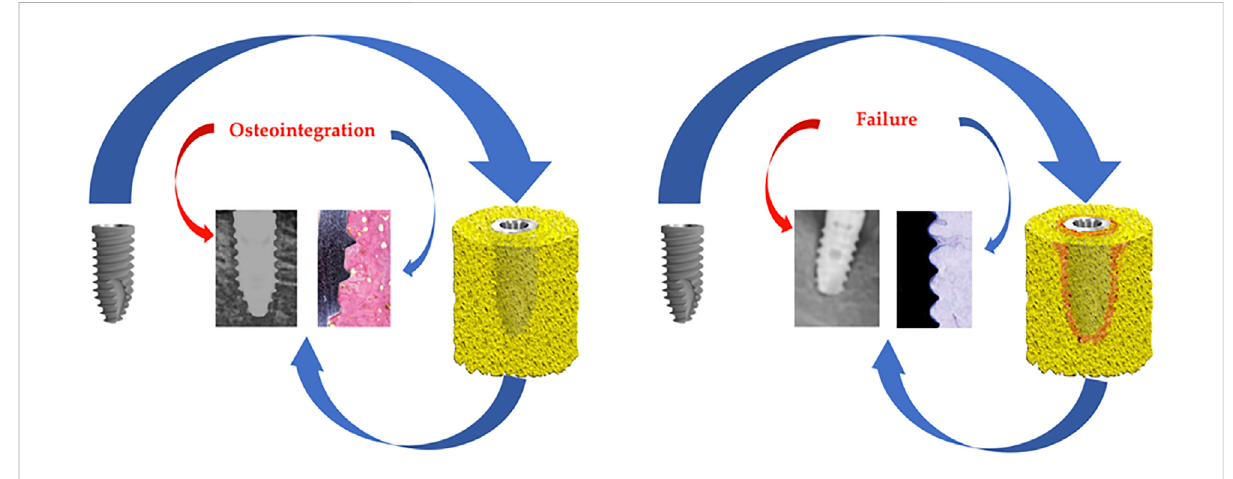
FIGURE 1 Osseointegration and failure.